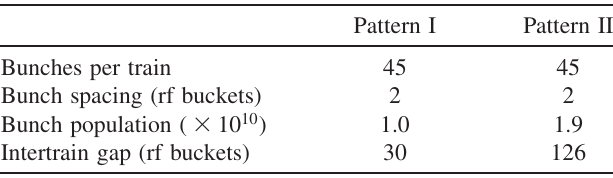
TABLE II. Fill patterns used in simulation studies.